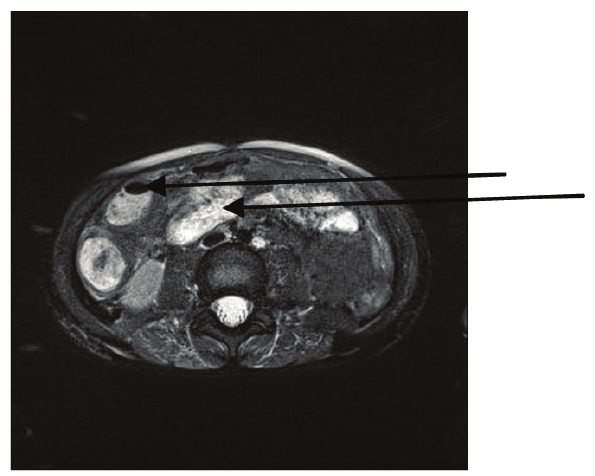
Figure 5. MRI scan of abdomen obtained on the 12th day of disease: edematous jejunal wall and distension with air fluid level in caecum